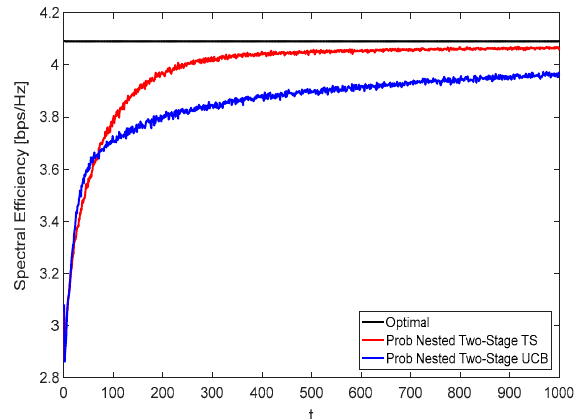
Figure 10. Spectral efficiency convergence at zero blockage using N = 36, M = 64, and K = 16.